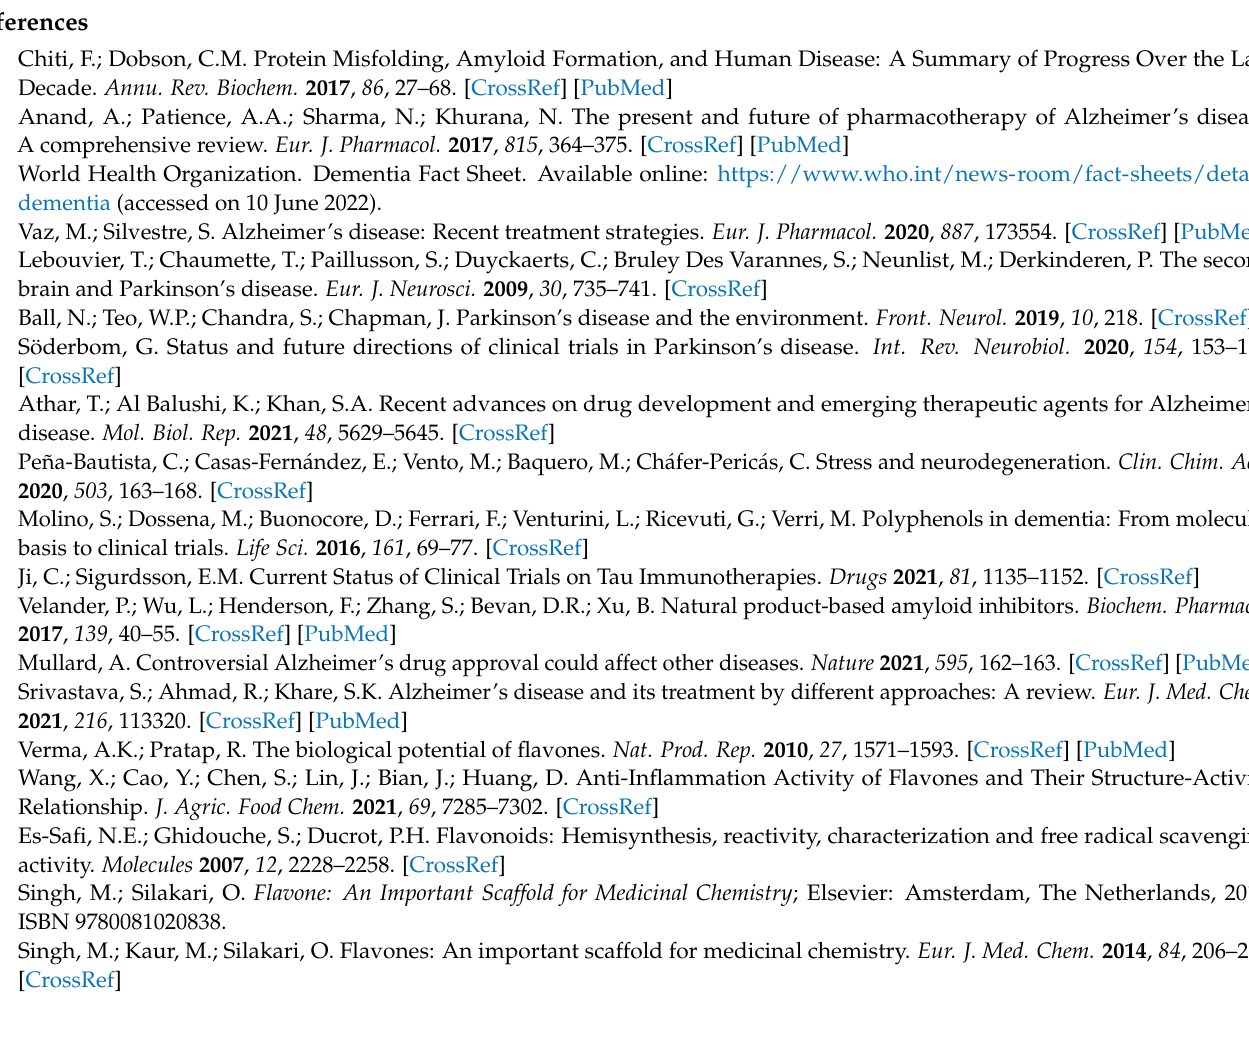
Figure S4: The kinetic curves of 1 µ M A β aggregation with 50 µ M and 100 µ M oDHF HW ; Figure S5: Atomic force microscopy (AFM) images of aSyn without (A) and with oDHF (B), oDHF LW (C) and oDHF HW (D). The fibril height (E) and width (F) distribution, where box plots indicate mean ± SD and error bars are in the 5–95% range (n = 50). The FTIR spectra of aSyn fibrils formed with or without inhibitors (G) and their second derivatives